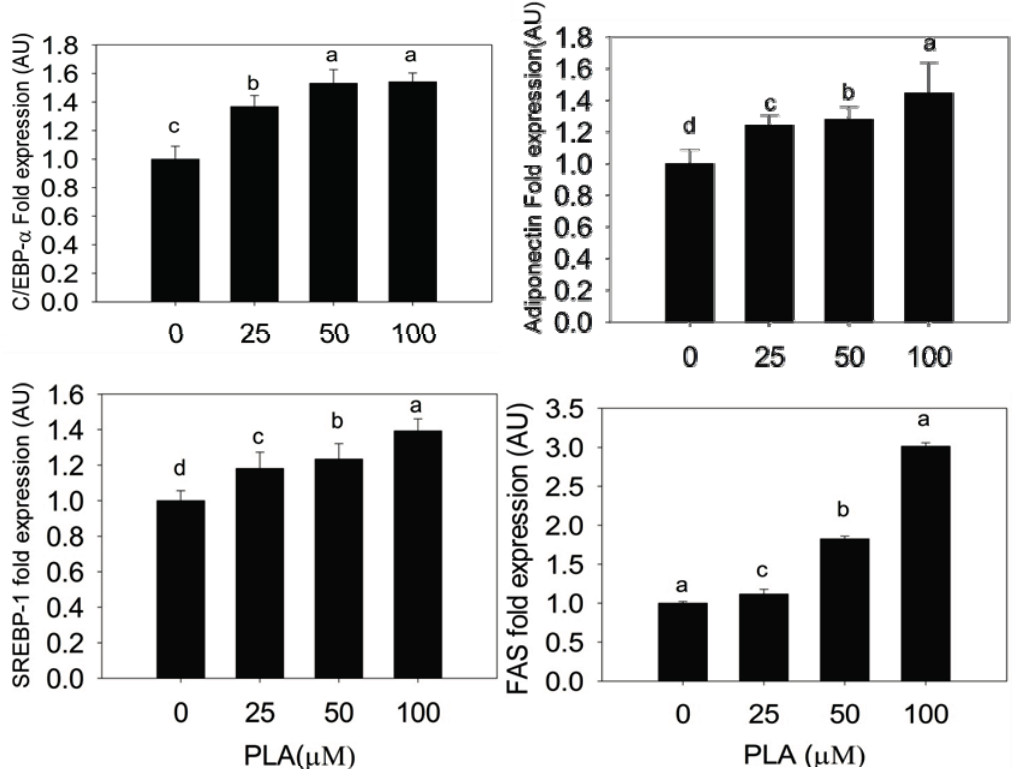
Figure 5. Immunoblot analyses of PPAR- γ 2, C/EBP- α , adiponectin, SREBP-1, and FAS. Bar diagram indicates fold expression of proteins (arbitrary units-AU) in differentiated adipocytes quantified by the Imagej software. Data were shown as means ± SEM of three replicates. Different letters a, b, c, d within a treatment indicate a significant difference ( p <